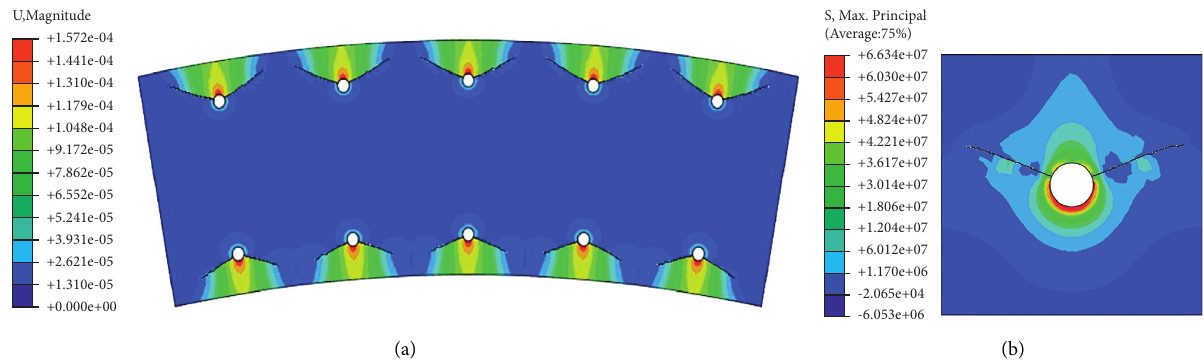
Figure 14: Degradation characteristics of the segment after 5 years of steel bar corrosion: (a) the displacement cloud during cracking and (b) the maximum principal stress cloud during